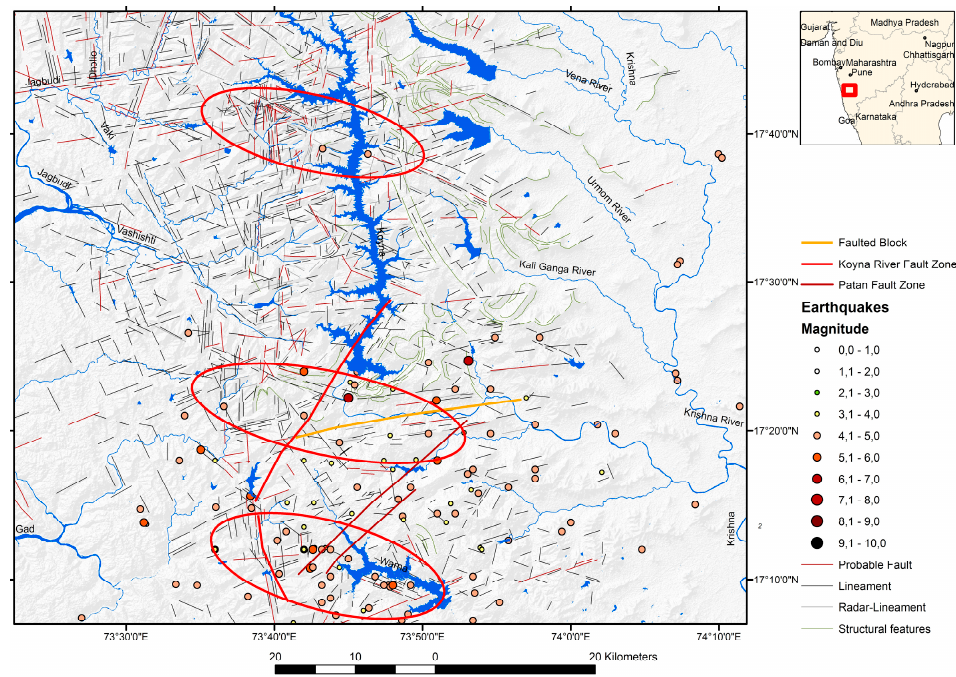
Figure 12. Lineament map based on evaluations of Landsat and Sentinel radar images. Red ellipses indicate intersections of distinct lineaments expressed by linear tonal and morphologic anomalies. The position of the Koyna River Fault Zone (KRFZ), the Koyna River Fault Block and the Patan Fault Zone are depicted after [48,49].